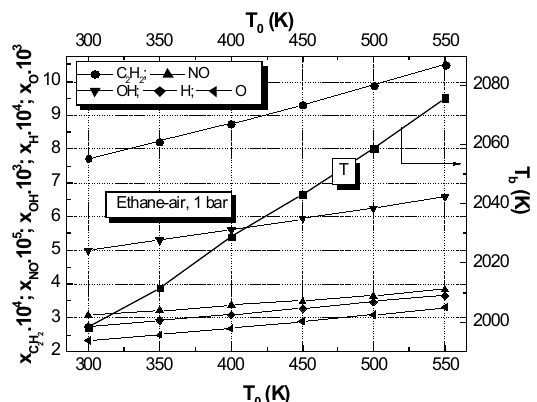
Figure 15. Initial temperature influence on end flame temperature and mass fractions of several intermediates in the flame front of the stoichiometric C p